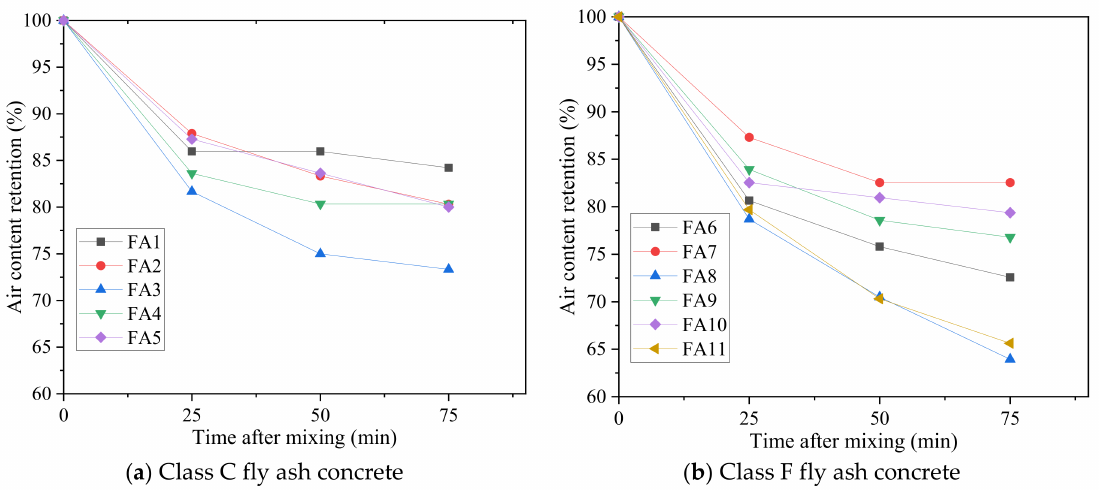
Figure 4. Air content retention of fresh fly ash concrete versus time ( a ) Class C fly ash concrete ( b ) Class F fly ash